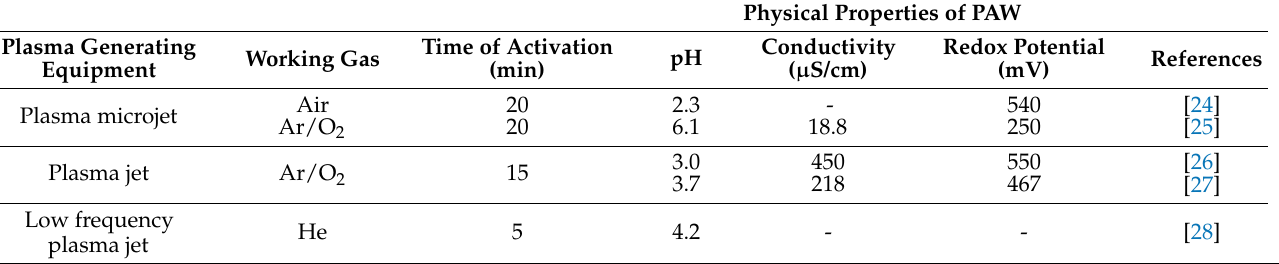
Table 1. Differences in physical properties of water, depending on plasma devices, working gas and activation